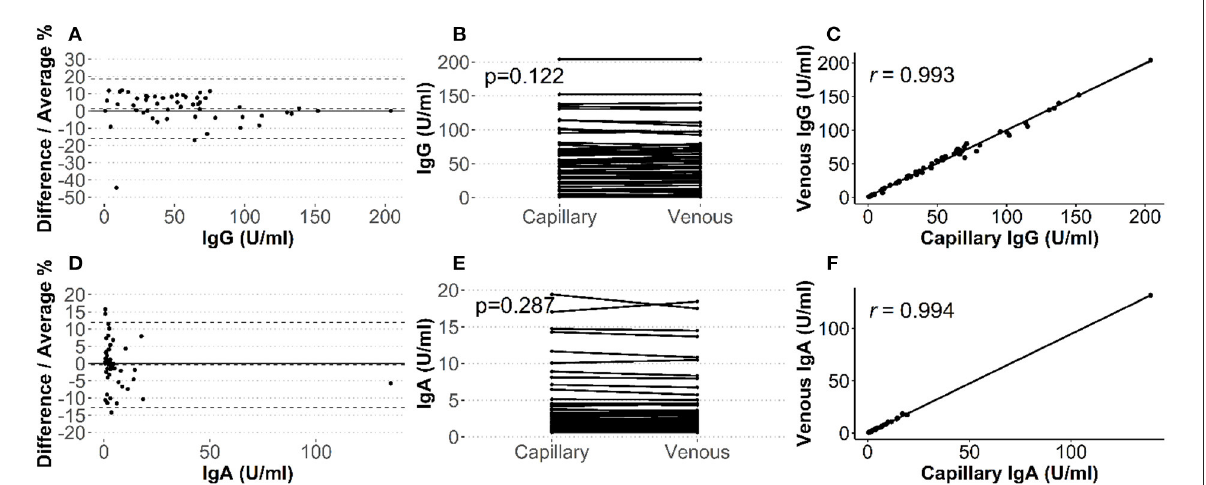
FIGURE3 Comparison of capillary and venous antibody levels. Single dots represents individual participants. Bland-Altman plot with dashed lines representing upper and lower 95% limits of agreement (A,D) , paired Wilcoxon signed rank test, and Spearman’s correlation analysis of measurements for IgA (A–C) and IgG (D–F) , respectively.